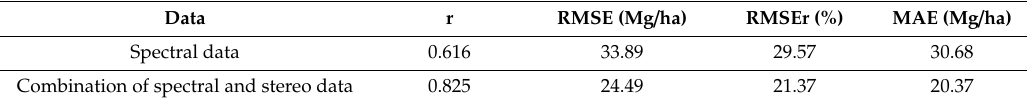
Table 4. A summary of evaluation